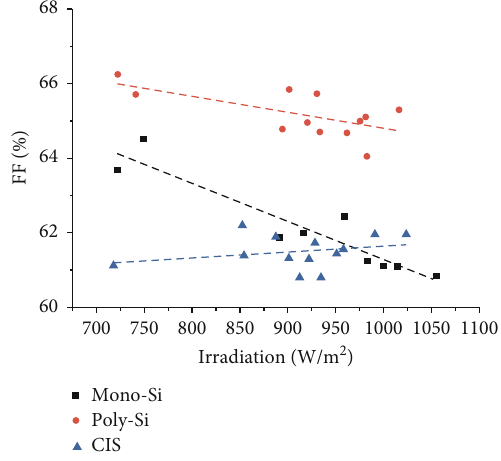
Figure 14: E ff ect of solar radiation on mono-Si, poly-Si, and CIS materials